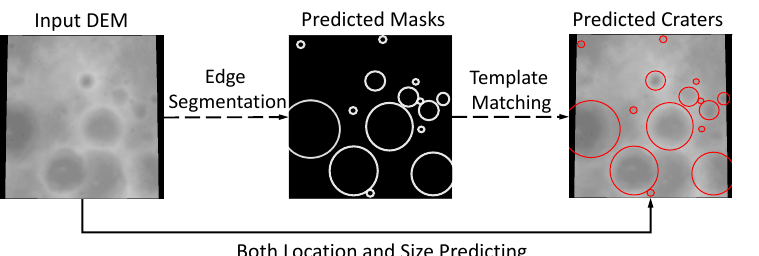
Figure 1. Comparison of the two-stage pipeline (dotted line) and the end-to-end pipeline (solid line) for lunar crater detection on the DEM